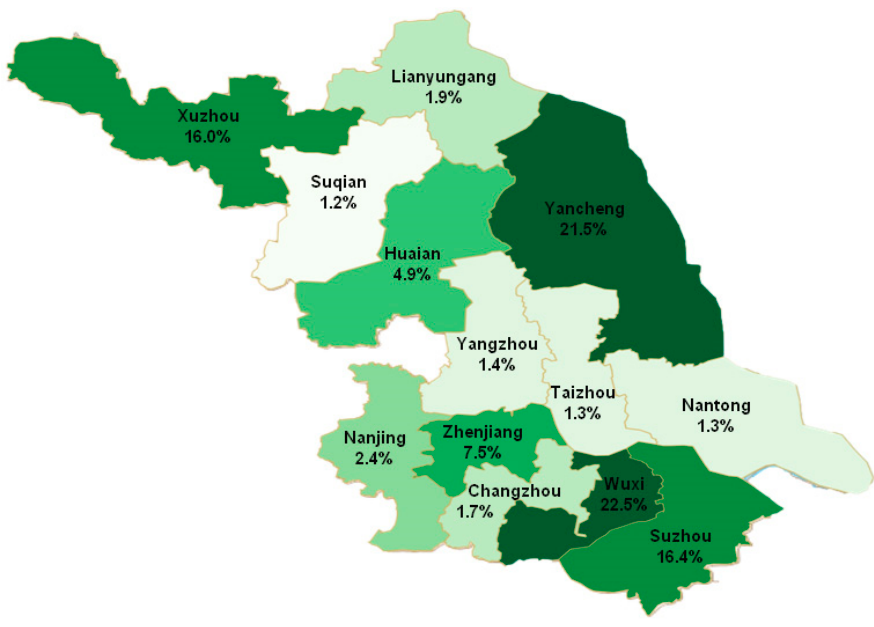
Figure 3. The regional distribution of pneumoconiosis cases reported from 2006 to 2017. Table 1. The regional distribution of pneumoconiosis cases reported from 2006 to 2017.